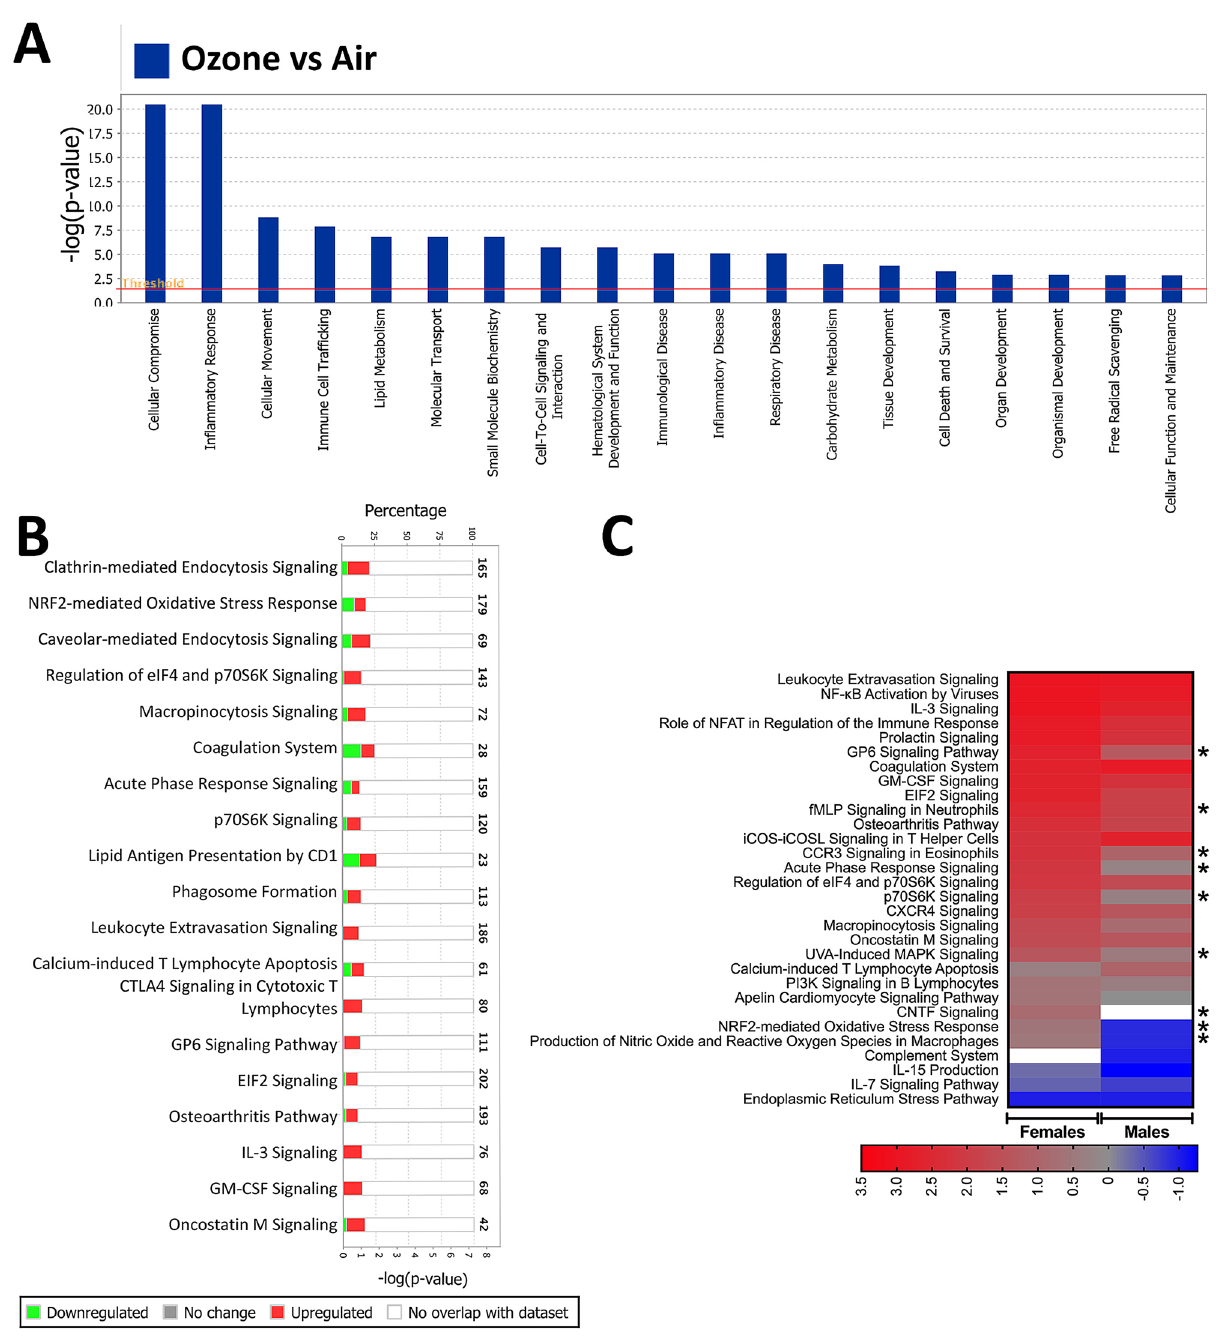
Figure 7. Comparative analysis of proteins in BALF exosomes from ozone- vs air-exposed mice reveal enrichment of inflammation/injury associated pathways. 1255 differentially expressed proteins (Total,1255; enriched, 568; low abundance, 687) were subjected to Ingenuity pathway analysis (IPA). Ingenuity pathway analysis (IPA) for the enrichment of ( A ) disease/functional pathways and ( B ) canonical pathways/biological networks altered in the exosomes from ozone-exposed mice. ( C ) IPA was performed to compare differentially expressed signatures in ozone-exposed males (versus air-exposed males; 380, enriched; 438, low abundance) and ozone-exposed females (versus air-exposed females; 427, enriched; 474, low abundance). Z-scores were used to plot heat maps. Only selected pathways are presented in this figure panel. A detailed heat map with all the differentially enriched pathways is included in Supplemental Fig.